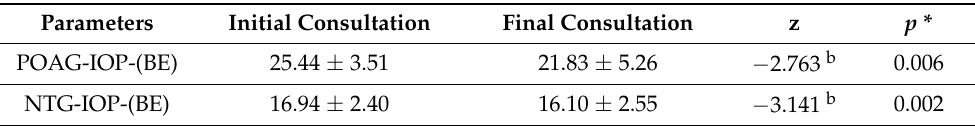
Table 3. Distribution of IOP parameters in POAG and NTG patients, at the first and last consultation. Parameters